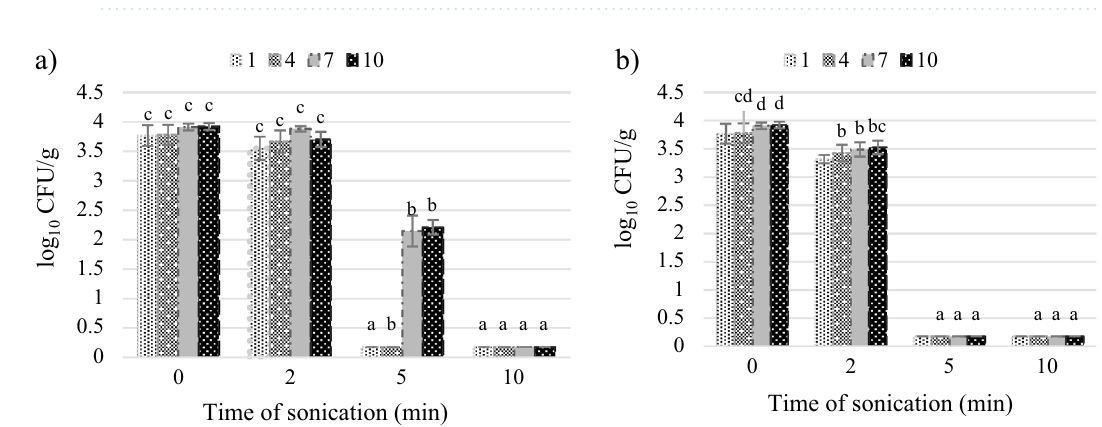
Figure 3. Effect of ultrasound intensity and sonication time on the coliform bacteria count: ( a ) intensity 28 W cm −2 , ( b ) intensity 40 W cm −2 .